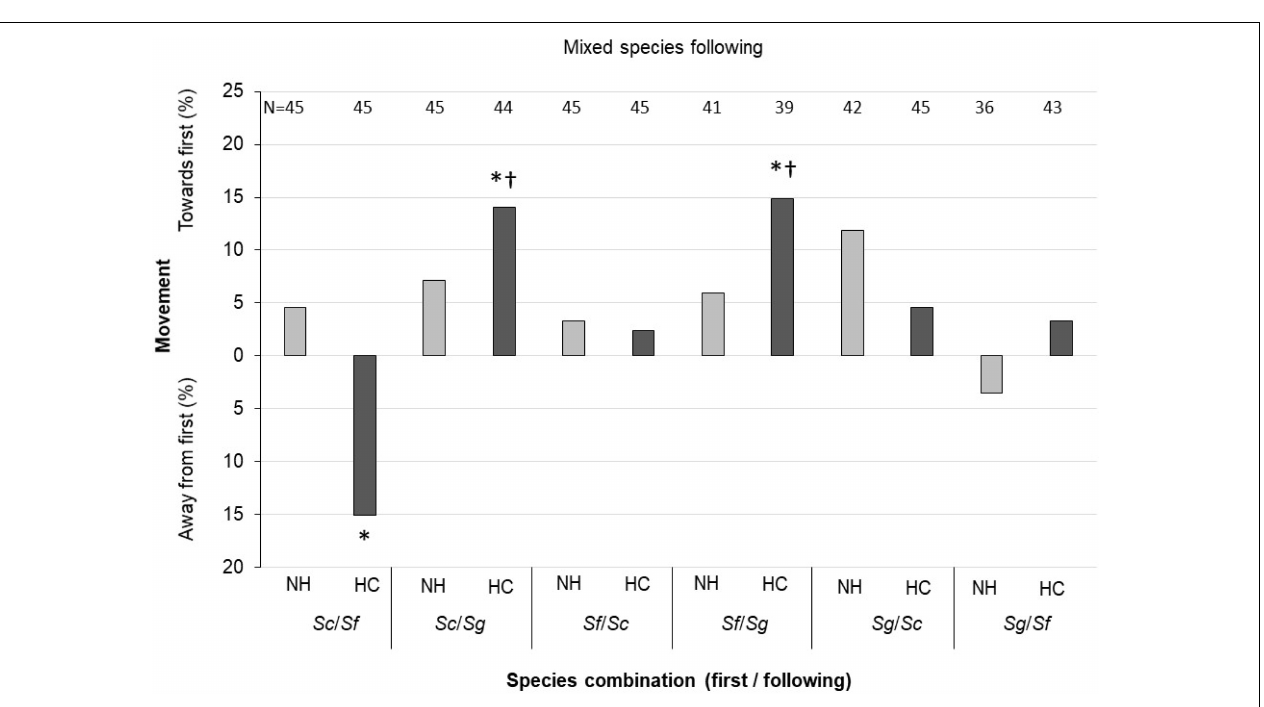
FIGURE 3 | Following response of IJs under mixed-species conditions. NH, first nematode without host contact, HC, first nematode with host contact. In pairs, the species listed first was the first nematode, the other species listed was the “following” species. Species combinations include Steinernema carpocapsae ( Sc ), S. feltiae ( Sf ), and S. glaseri ( Sg ). Binomial analysis. * P ≤ 0.05. † indicates analysis was only statistically significant when “following” IJs that did not leave the introduction point (i.e., that did not move) were excluded from analysis. Sample size for each condition listed above each bar; assays were attempted 45 times in all cases, but instances in which the lead IJ left the arena led to a total sample size of fewer than